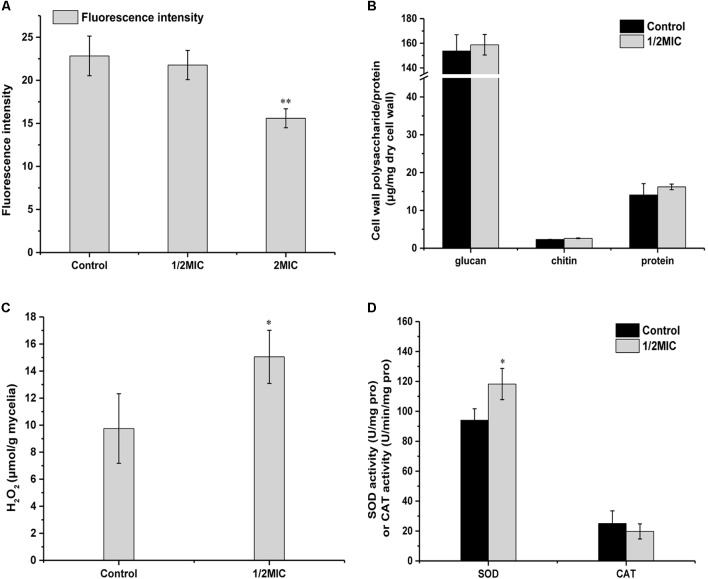
Effect of Cin/Cit on MMP (A), cell wall polysaccharide and protein (B), H2O2 content (C), SOD and CAT activities (D) of P. expansum F-WY-12-02. Bars represent the standard deviation of the treatment means. ∗p < 0.05, ∗∗p < 0.01.